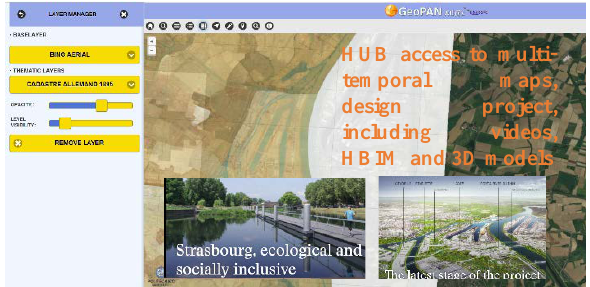
Figure 7. The integration of the available maps data with the design purposes joining landscape preservation